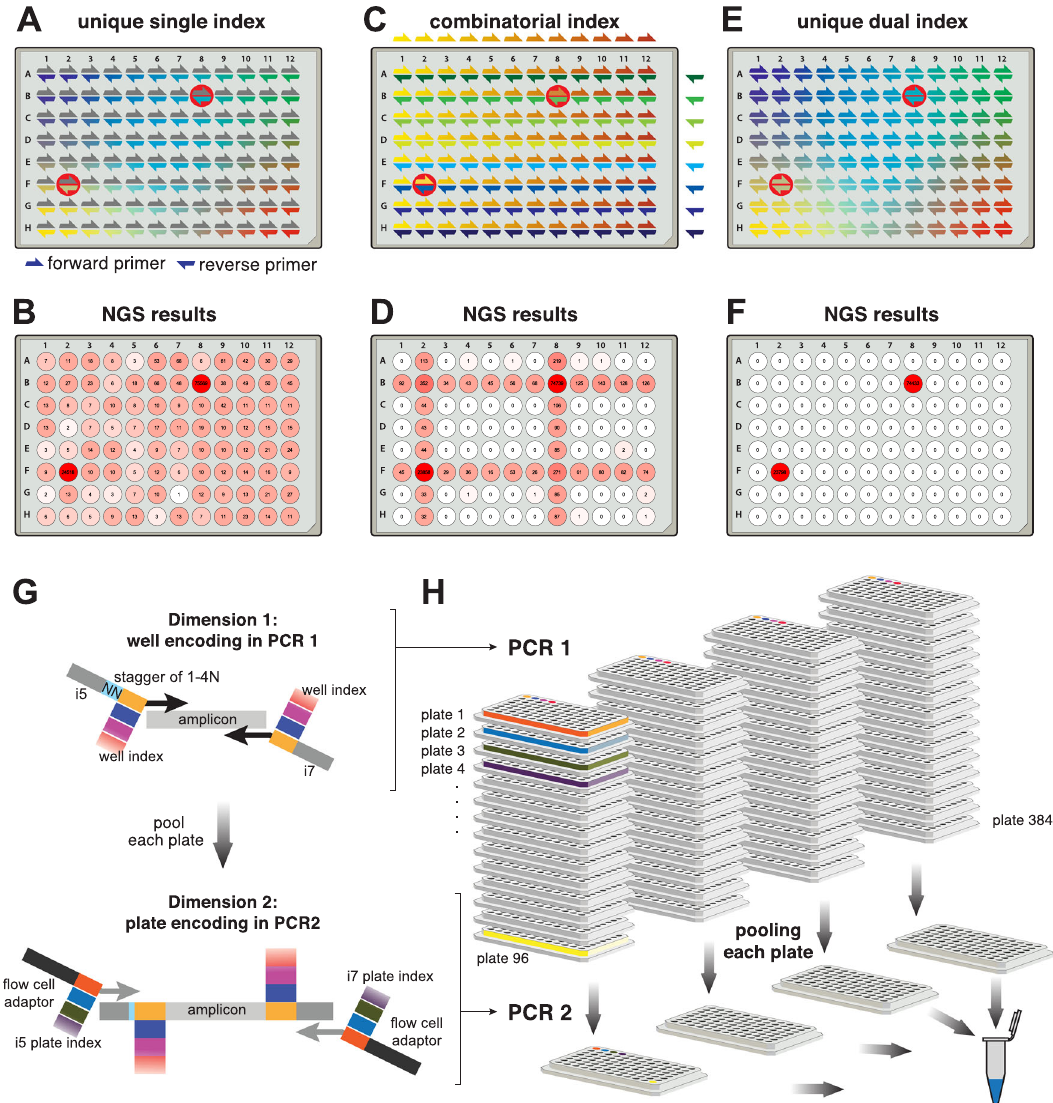
Fig. 2 Two-dimensional redundant dual indexing allows scaling to population-level testing. A Scheme depicting 96-well-speci fi c indices. These can be incorporated by forward or reverse primers. For the latter they can be incorporated during RT or PCR. Red circles highlight the positions into which synthetic SARS-CoV-2 RNA was added to test speci fi city of the indexing strategy. B N3 amplicon reads obtained by NGS and mapped to each well based on indices incorporated by reverse primers during PCR. Forward primer indices were present but disregarded in this analysis. Note the frequent misassignment to incorrect positions. C Scheme depicting combinatorial indexing. Each well is identi fi ed as a unique combination of a forward and a reverse index. D N3 amplicon reads mapped to wells based on combinatorial indexing as in C . To simulate combinatorial indexing the identical dataset as in B and F was used but for analysis, primers were treated in pools pointing to columns or rows. E Unique dual indexing is a redundant indexing method that encodes each well both by a unique forward and a unique reverse index. Thus, illegitimate recombination products between an amplicon and its associated indices can be bioinformatically rejected. F NGS result for the same dataset as in B and D analyzed with unique dual indices successfully fi ltered away all misassigned reads. G Two rounds of unique dual indexing (in two subsequent PCR reactions) can be used to index fi rst wells and then plates, effectively achieving combinatorial (multiplicative) scaling. Colored boxes represent indices. H Illustration of the PCR work fl ow. RT and PCR1 are performed on all samples individually, adding well-speci fi c indices. Subsequently, each plate is pooled to one well of a new plate, reactions are treated with Exostar to remove excess primers and a second PCR is done, adding plate-speci fi c indices and the Illumina fl ow cell adaptors. Our currently used and validated index set allows pooling of up to 36,864 samples (96 in PCR1 × 384 in PCR2). Finally, PCR2 amplicons are pooled, gel puri fi ed, and sequenced on any Illumina